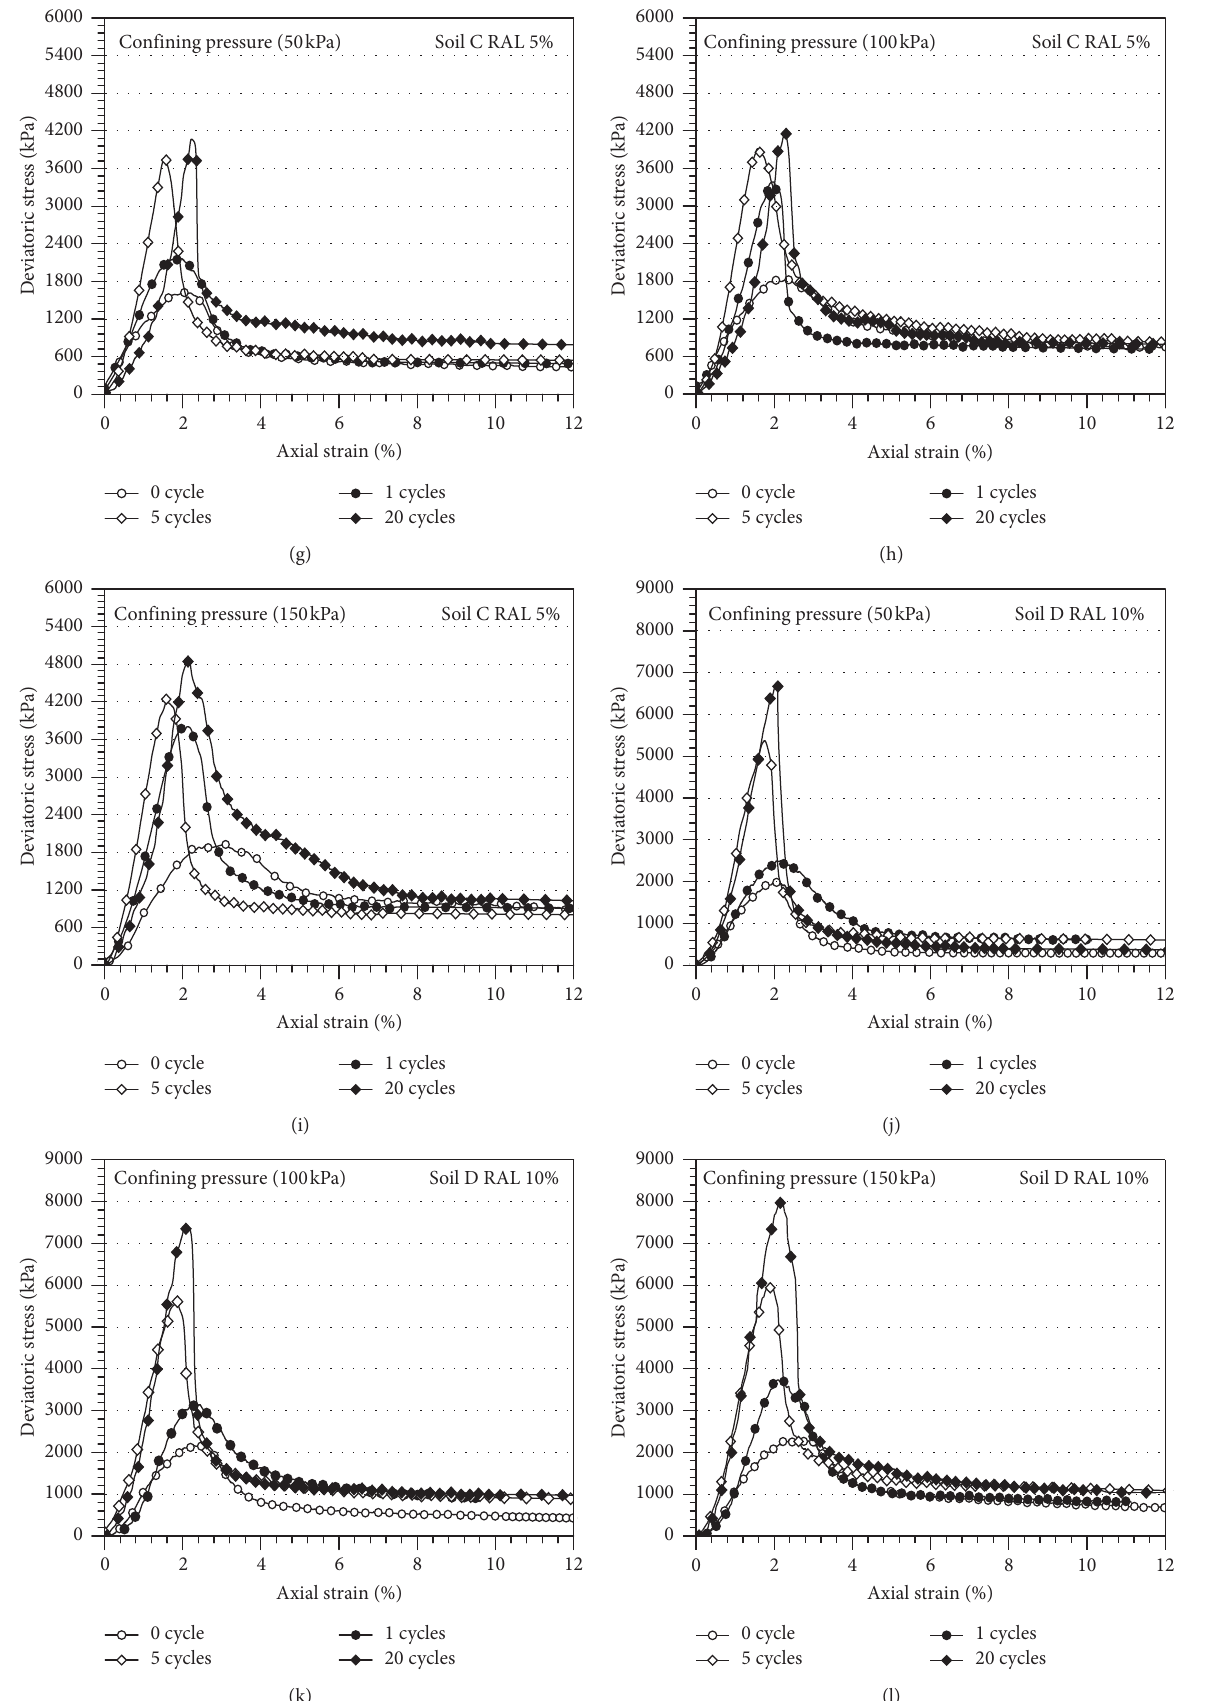
Figure 3: Stress-strain curves of the untreated and lime-stabilized